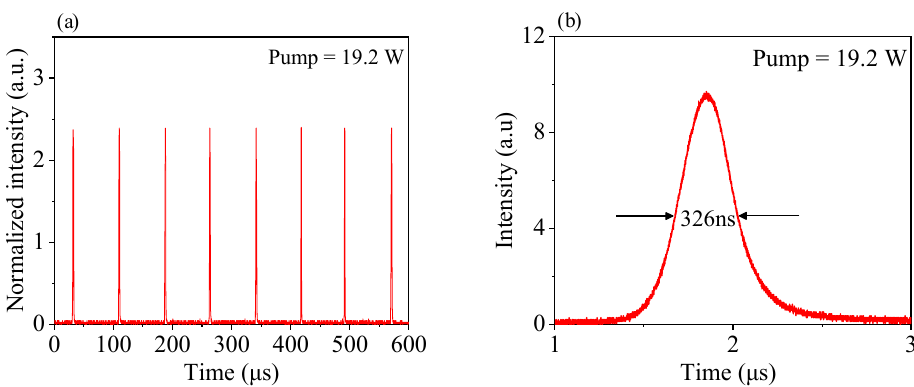
Figure 7. ( a ) Pulse trains and ( b ) single pulse shape of the gain-switched Ho:LLF laser at a pump power of 19.2 W.